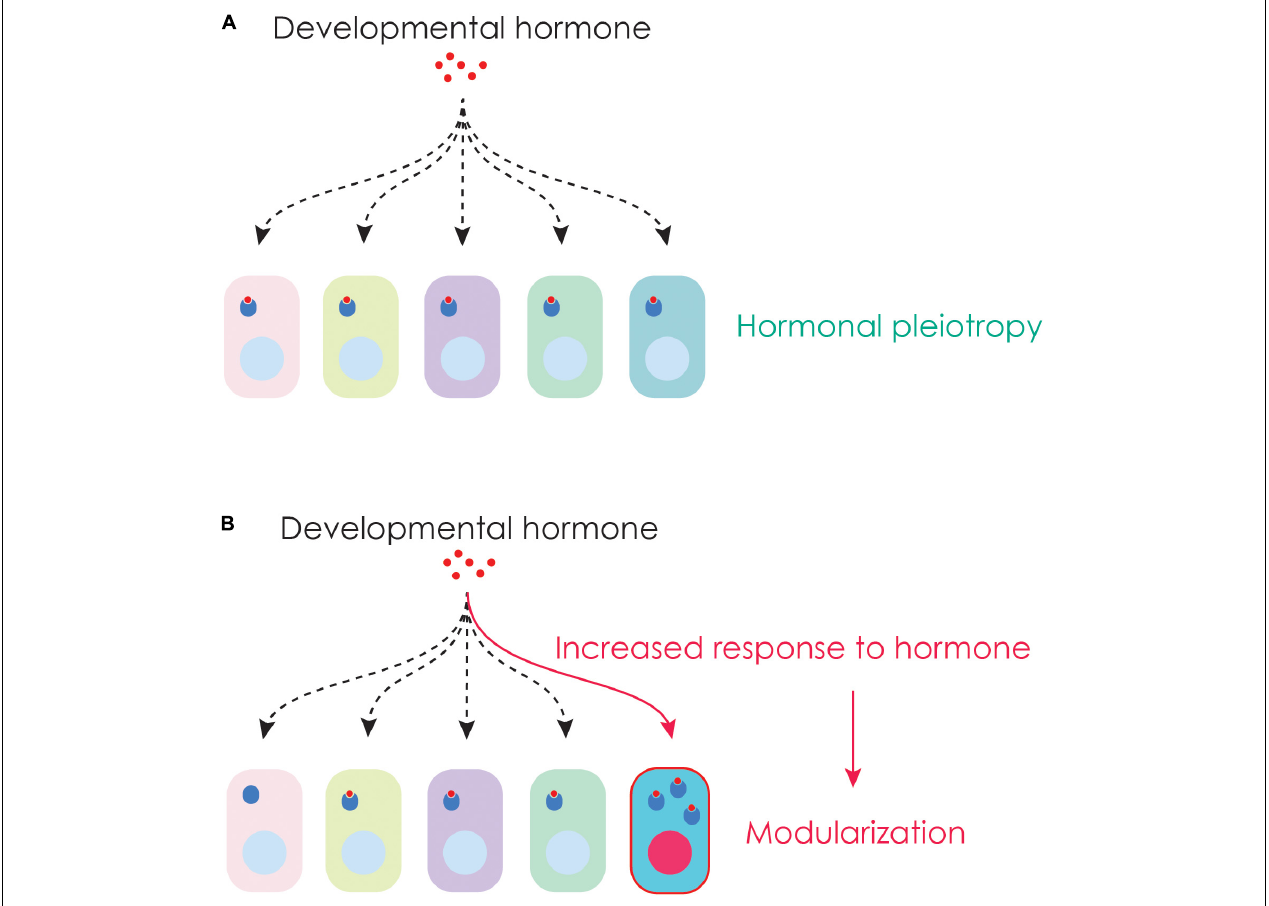
FIGURE 4 | Hormonal pleiotropy and modularization. (A) Hormonal pleiotropy occurs when one hormone impacts many tissues at the same time. (B) Specific tissues can overcome constraints imposed by pleiotropy by evolving a unique response to hormones. Such changes could arise, for example, by the cells becoming more sensitive to hormones by producing additional hormone